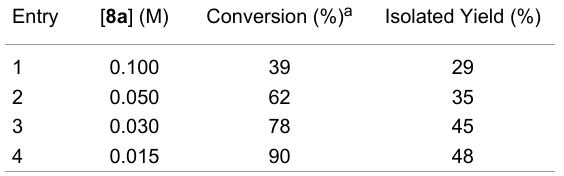
Table 1: Effect of aryl azide concentration on conversion.